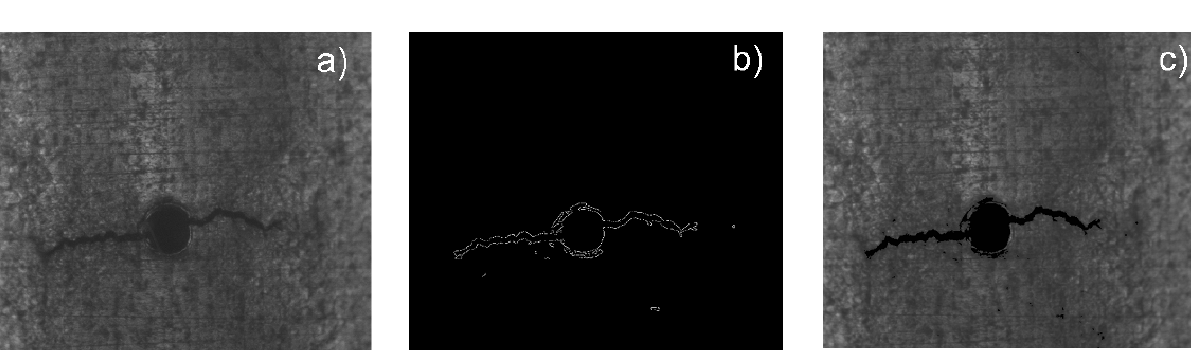
Figure 6: Image of sample S1 at maximum strain after applying 800 cycles. a) Raw image, b) image of the crack detected with the algorithm and c) detected crack superimposed on original image. The diameter of the hole is 150 μ m.